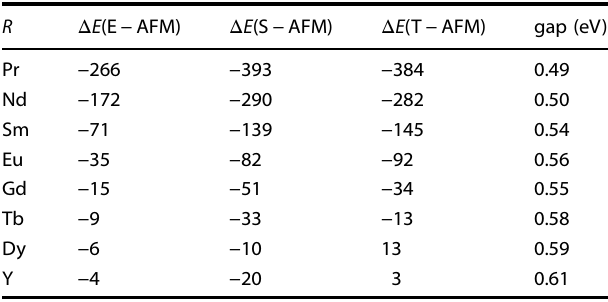
Table 1. Key quantities of the different relaxed ground